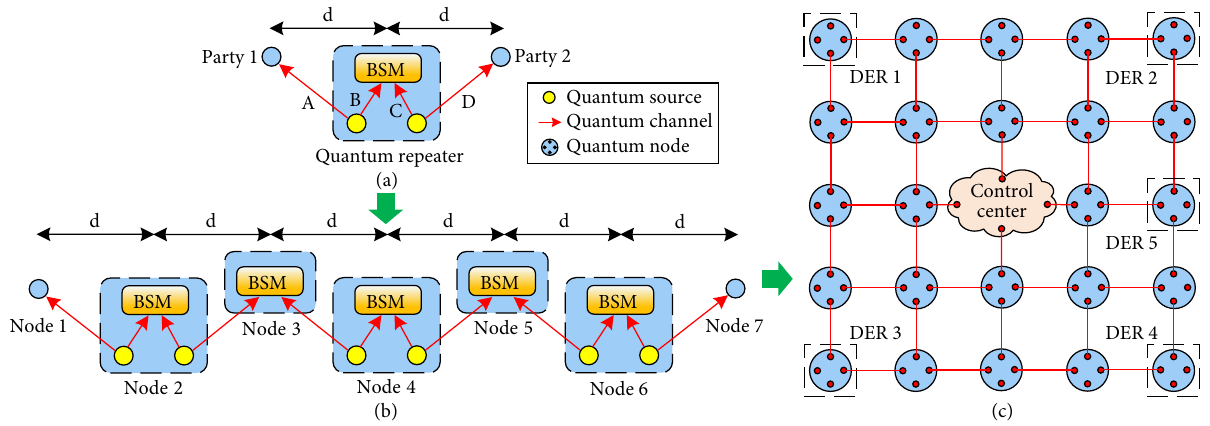
Fig. 8 A QKD-based quantum network using quantum repeaters [28] . (a) Illustration of a quantum repeater. (b) A chain of quantum repeaters. (c) The quantum network. BSM: Bell State Measurement. Quantum node: A quantum repeater (including a node with only the measurement capability) or a communicating party. d is the distance between two quantum